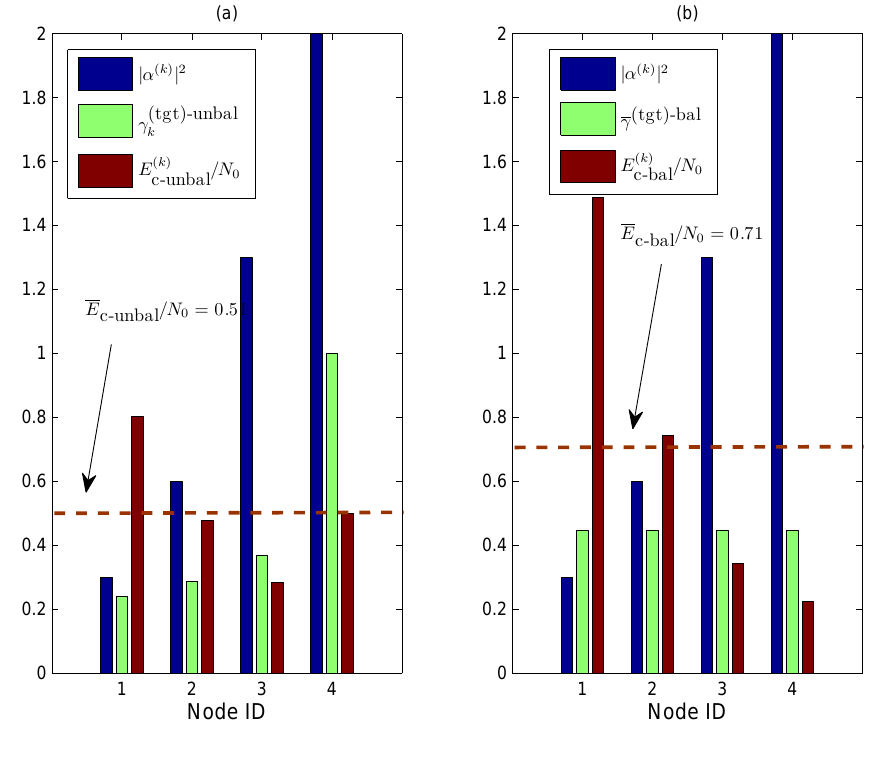
Figure 3. Illustrative comparison, in terms of target SNRs at the AP and at the transmitters, between (a) ideal unbalanced SNR and (b) ideal balanced SNR feedback power control strategies in a scenario with n = 4 sources and ρ = 0 . 95